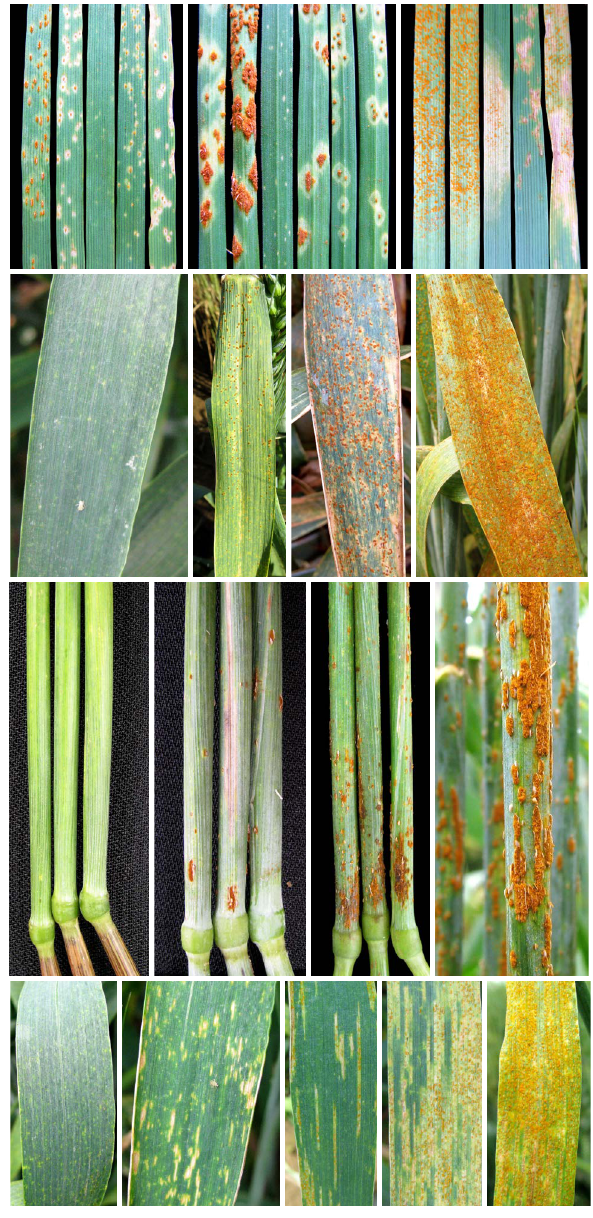
Figure 1: Seedling (top, left to right: wheat leaf rust, stem rust and stripe rust) and adult plant phenotypes commonly encountered for leaf rust (second from top), stem rust (third from top) and stripe rust